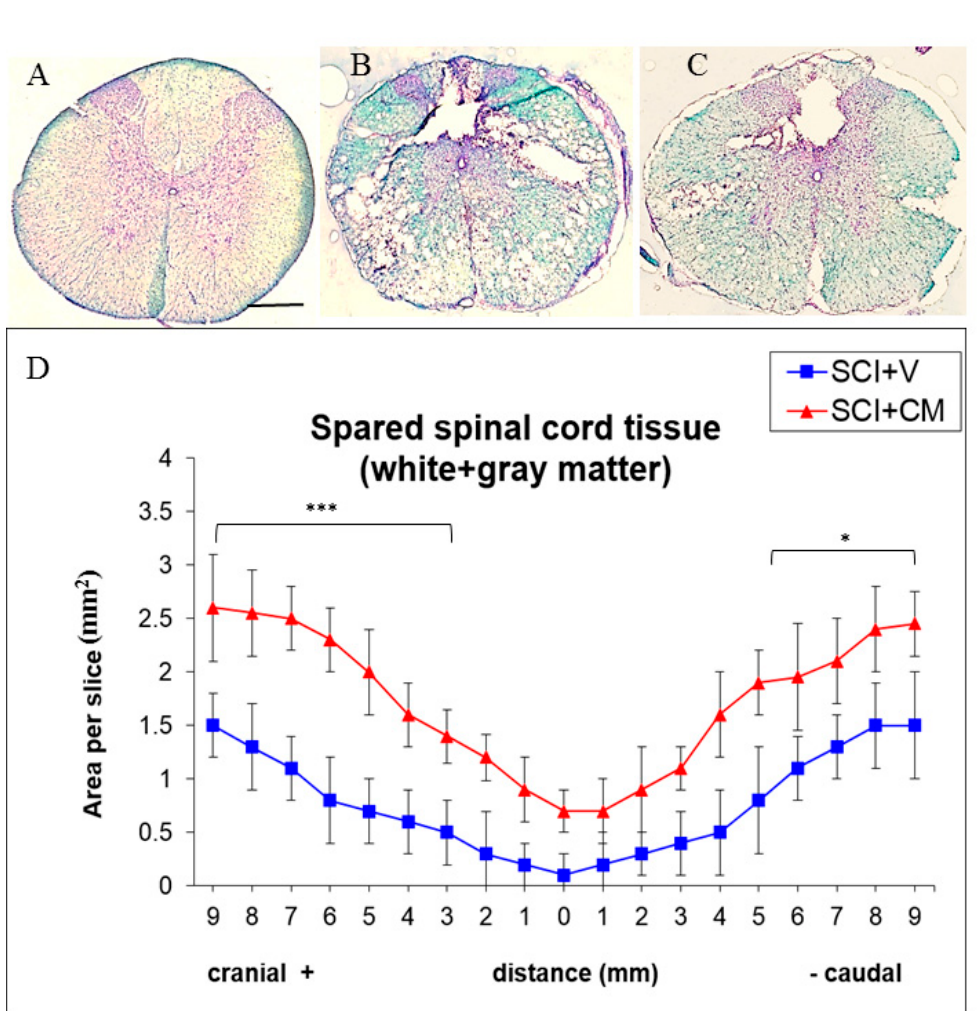
Figure 4. Representative cross section of spinal cord, Th8 stained with luxol fast blue of: control ( A ); SCI treated with vehicle (SCI + V) ( B ); and treated with MScCM (SCI + CM) ( C ). Quantitative stereological analyses of tissue fenestration in 1.8 cm (0.9+/ − ) segment ( D ). Note, there are significant differences of spared tissue (gray and white matter) between SCI + V (blue line) and SCI + CM (red line) treatment in most cranial and caudal sections (*** p < 0.001, * p < 0.05). Scale bars ( A – C ) = 500 μ m.